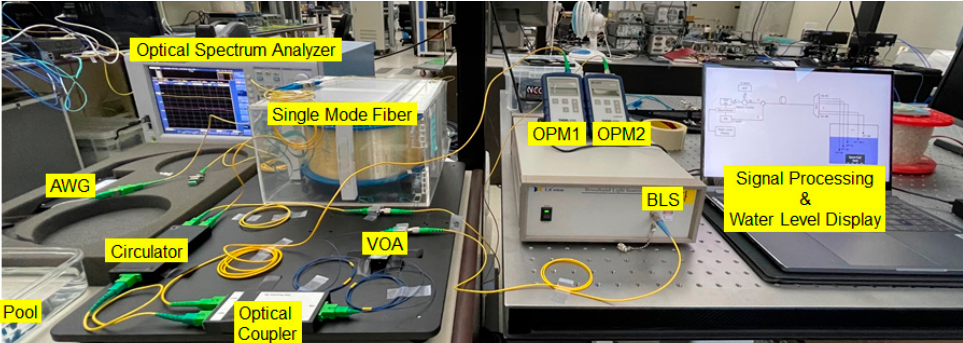
Figure 3. Experimental setup for demonstration of the dense wavelength division multiplexing (DWDM)-passive optical fiber sensor network based on single-path configuration.